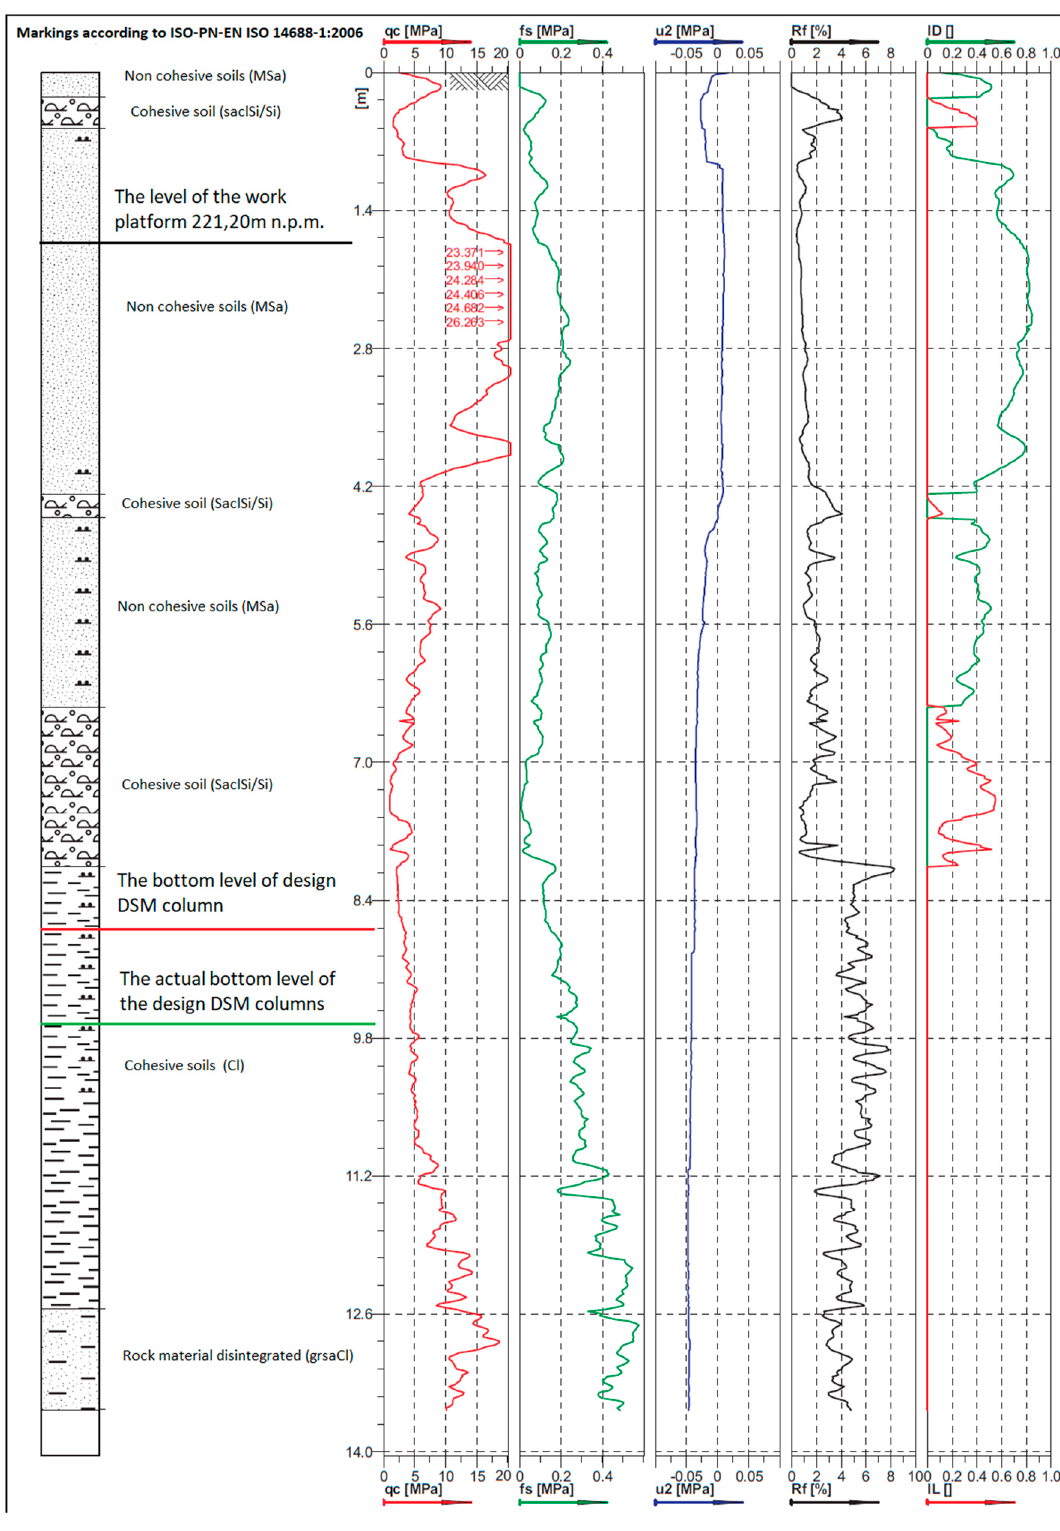
Figure 4. Results of the complementary CPTU survey—probe No. 8.